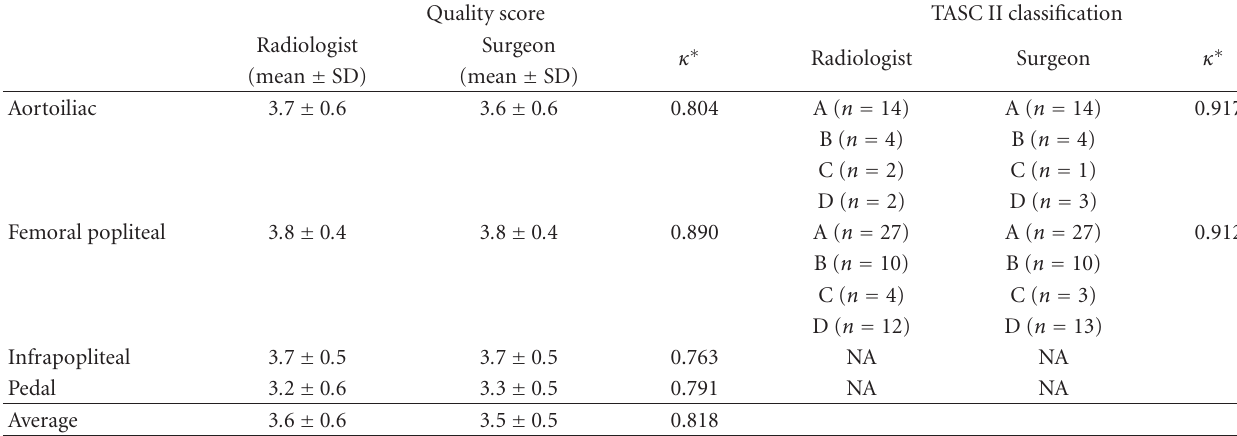
Table 2: Agreement of quality scores and TASC II classification of T-MRA between the radiologist and vascular